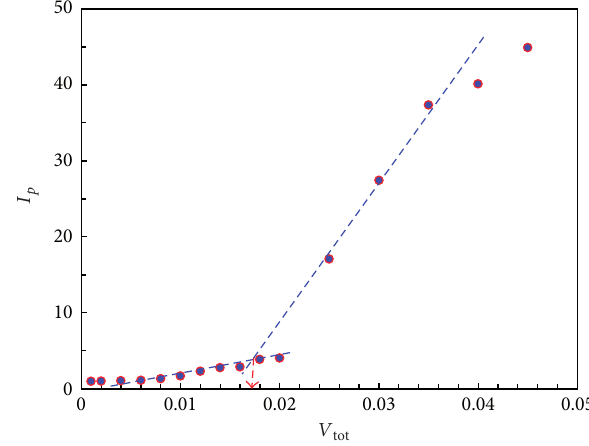
as a single chain as a single chain surfactant. From this graph CMC is estimated H T by 0.09. e slope of the graph reduces aer CMC. 3